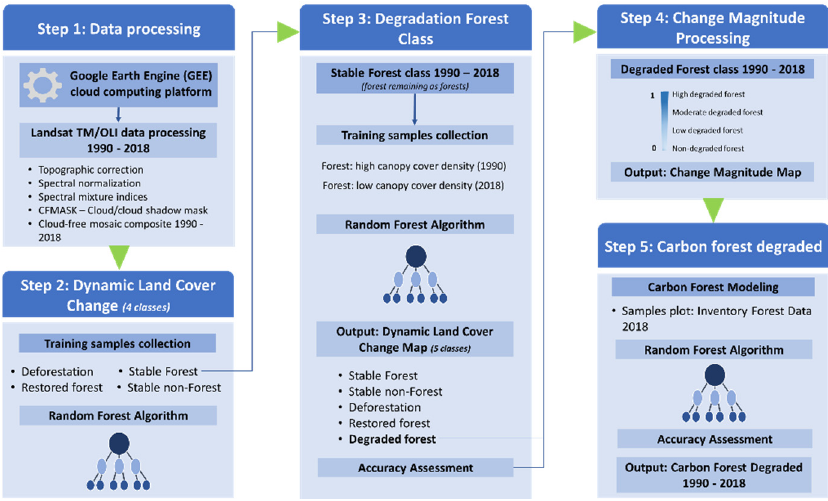
Figure 3. Flowchart: representation of the methodology used in our research.